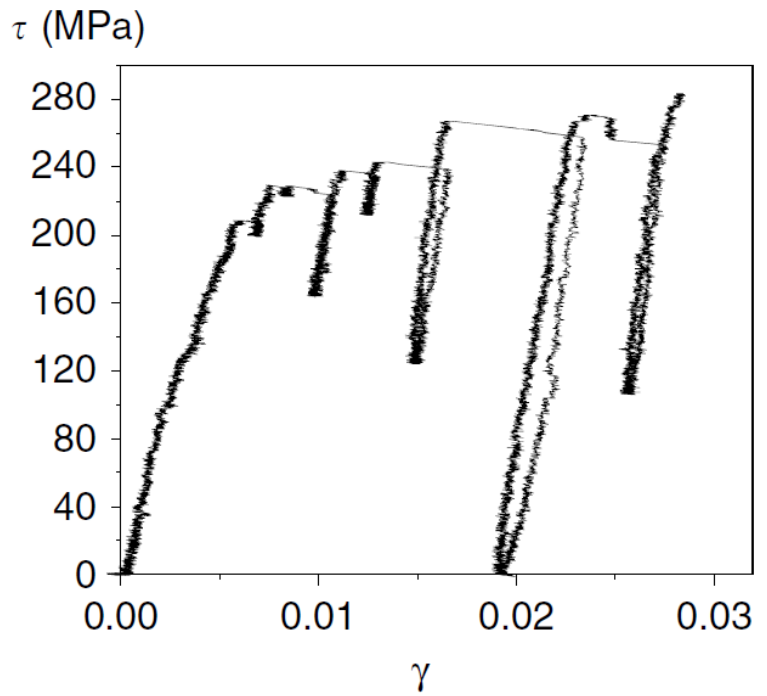
Figure 23. The stress vs. strain curve for the in situ TEM nanopillar compression tests for the Al 0.1 CoCrFeNi HEA (reproduced from Reference [160]).